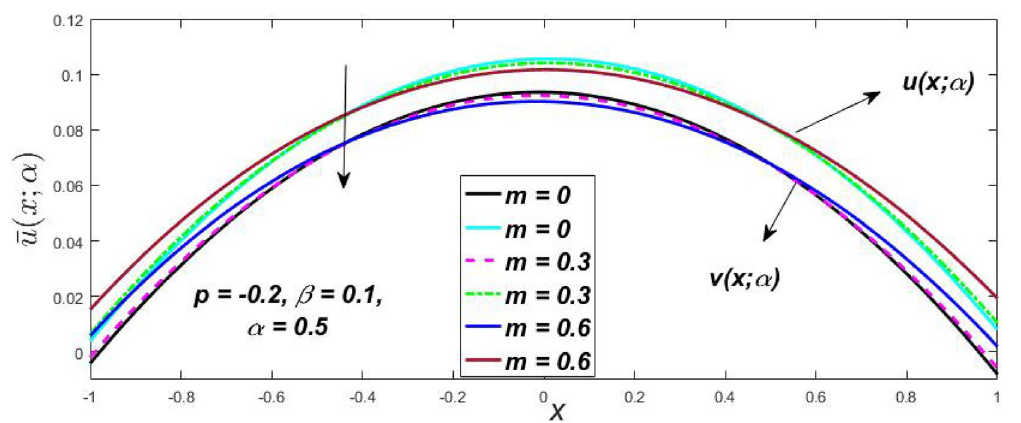
Figure 21. Fuzzy velocity profiles for the impact of